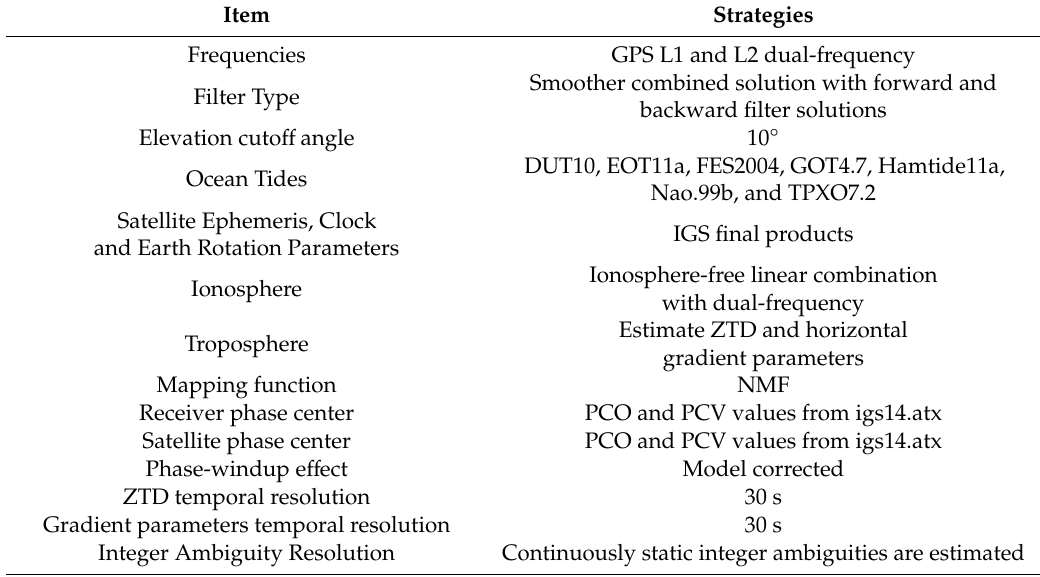
Table 3. Data processing strategies with precise point positioning